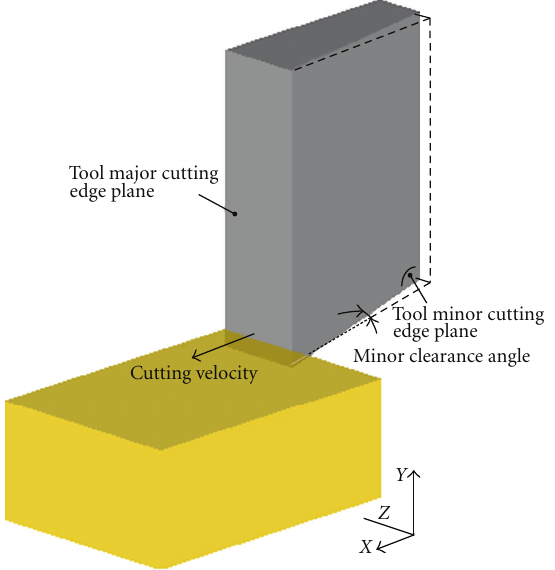
Figure 10: The definition of minor clearance